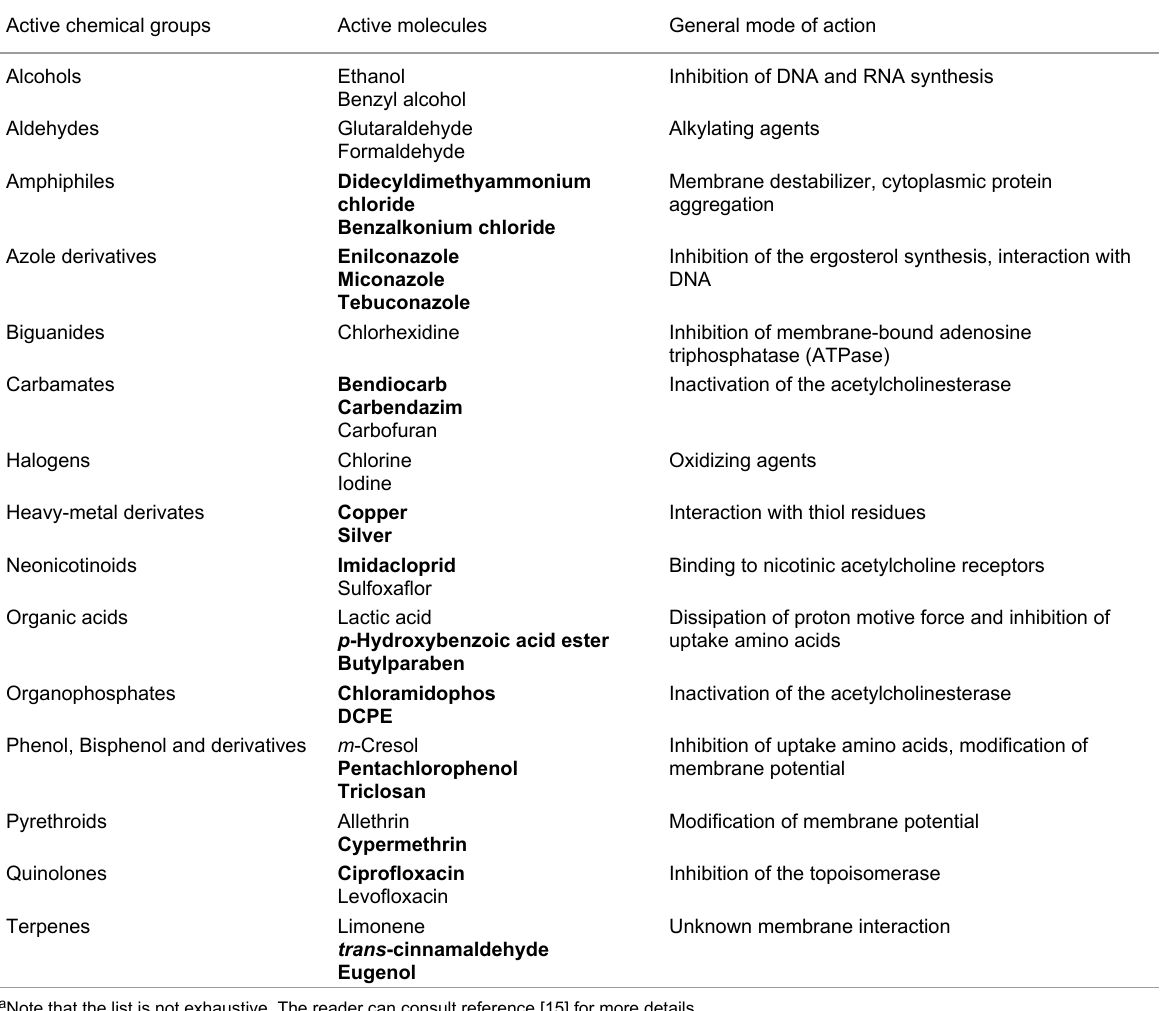
Active chemical